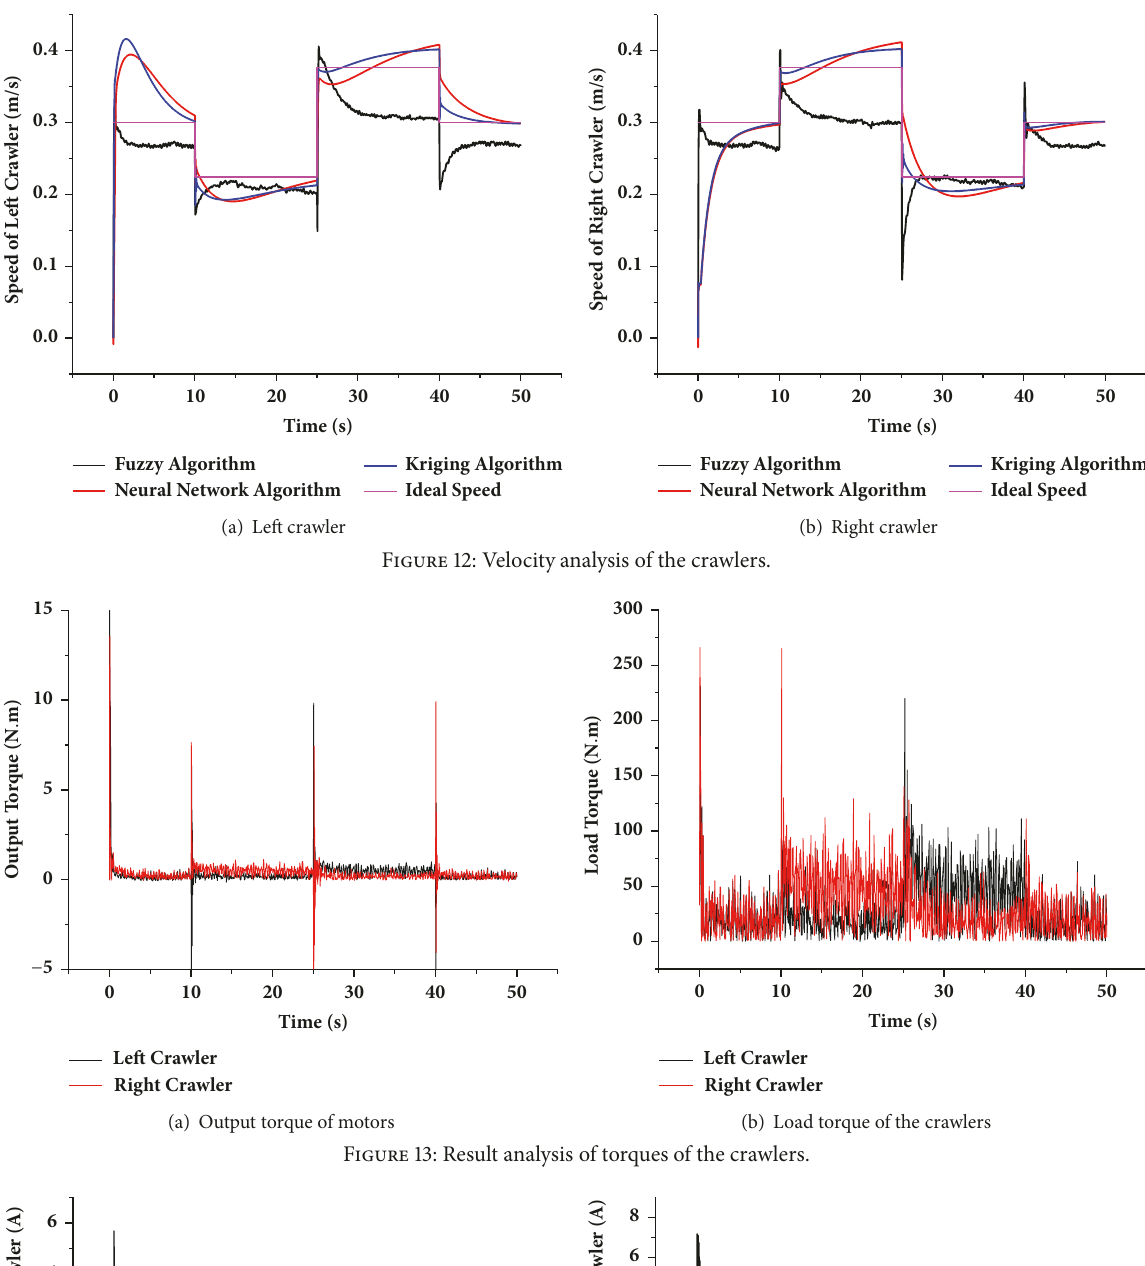
Figure 13: Result analysis of torques of the crawlers.